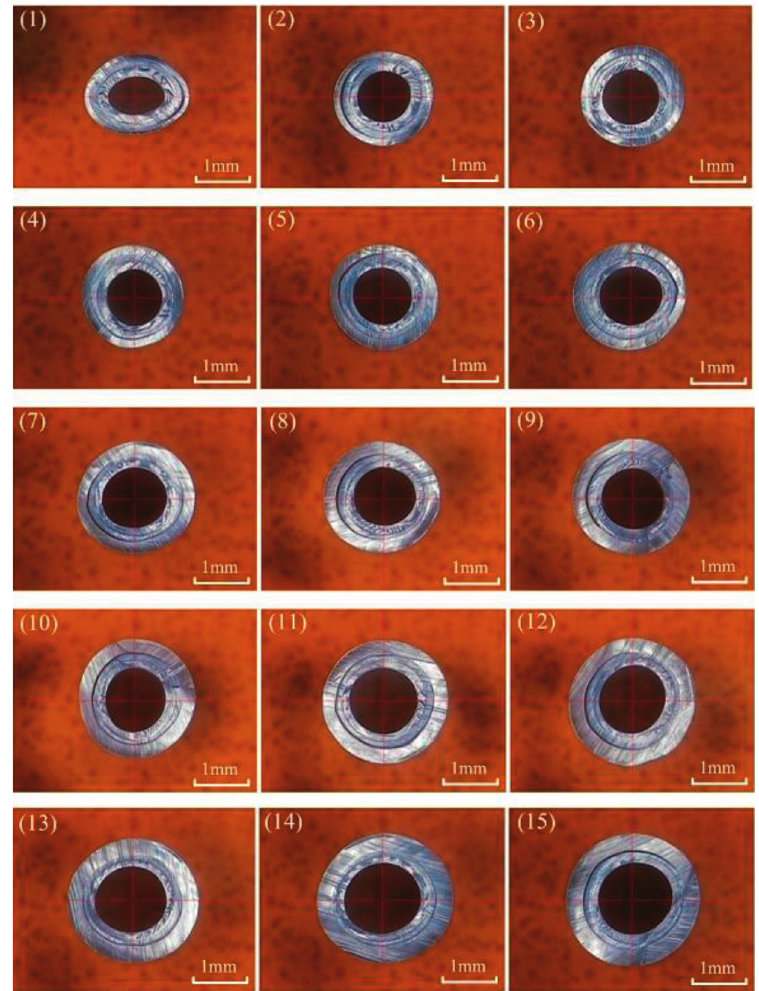
N � 6 r/min, (b) N � 8 r/min, (c) N � 10 r/min, w ). (a) w 1 w 2 w 3